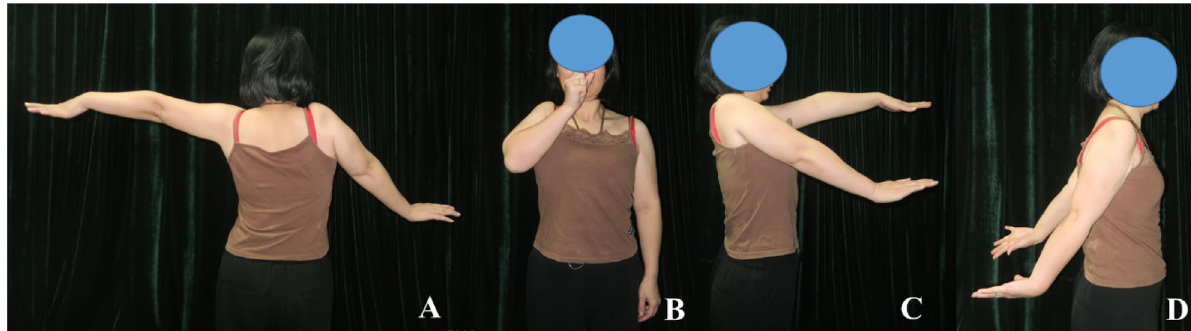
Figure 5. The photographs 10 years postoperative showed the function and the range of active movement of the shoulder